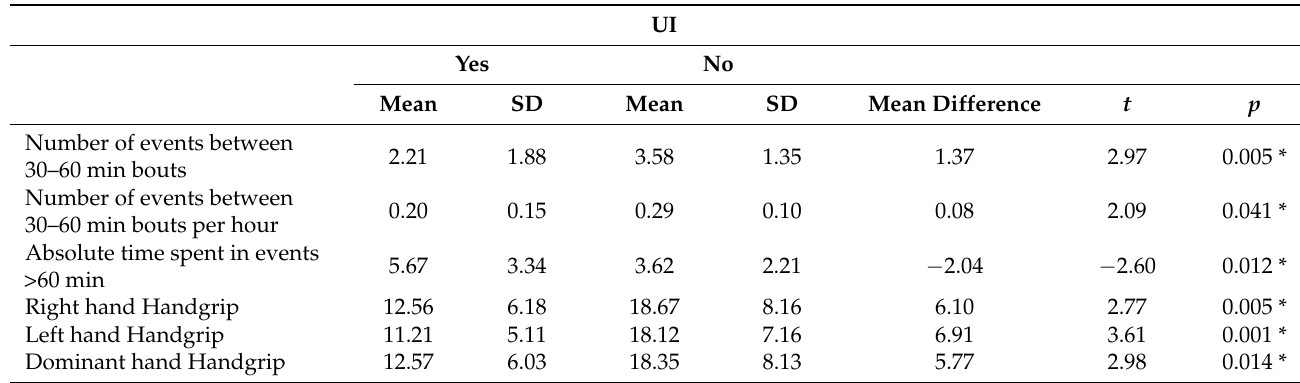
Table 7. Association between urinary incontinence (UI) and non-parametric variables